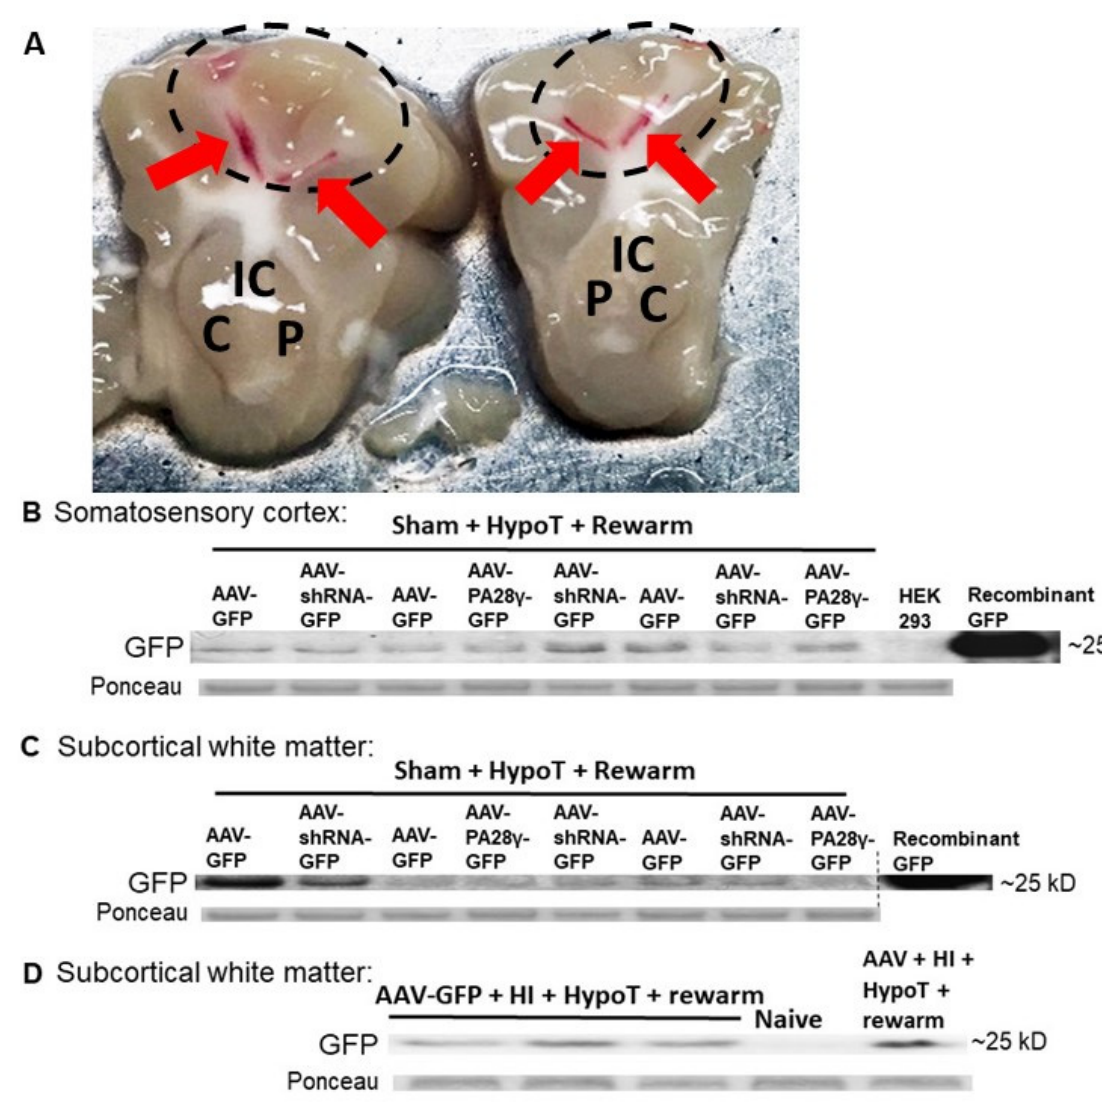
Figure 7. Western blots for green fluorescent protein (GFP) immunoreactivity confirmed adeno-associated virus (AAV) infectivity and transgene expression in piglets that underwent sham procedure and hypothermia or hypoxia-ischemia (HI) and hypothermia. ( A ) Examples of stereotaxically guided injection sites (red arrows) are shown in the subcortical white matter of the somatosensory gyri (dashed ovals). C, caudate; IC, internal capsule; P, putamen. ( B , C ) Piglets received